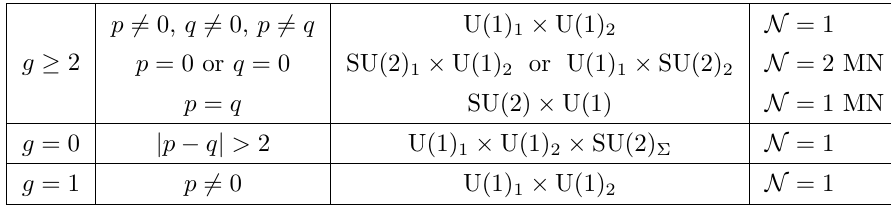
Table 1 . Summary of the values of p , q that yield smooth AdS 5 solutions in M-theory. Recall p + q = 2( g − 1) . In the third column we list the isometries of the internal space M 6 . In the last column, MN stands for Maldacena-Nuñez and refers to the solutions of